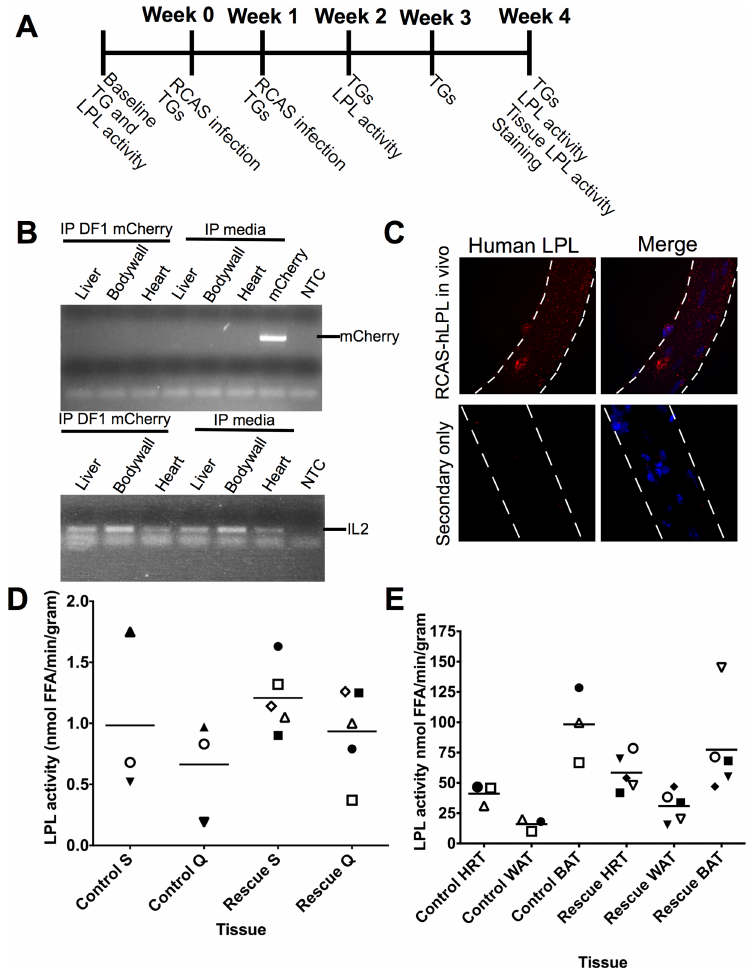
Fig 3. Expression of hLPL in striated muscle following in vivo infection with RCAS-hLPL. A. A schematic of the RCAS rescue strategy and data collectiontime points. RCAS-hLPL or RCAS-mCherry producing cells were injected into mice at week 0 and 1. Fasting serum triglycerides (TG) were measuredat all indicatedtime points. Post-heparin LPL activity (LPL activity) was measuredat baseline, week 2 and week 4 post infection. At 4 weeks post infection, animalswere sacrificed, striated muscle samples analyzedfor tissue specific LPL activity and myofibers isolated to perform immunostaining for hLPL. B. (Upper) Representative PCR for mCherry gDNA from various tissues of mck-Cre;lpl -/+ ;Rosa26 LSLTVA lacZ+/+ mice two weeks post-injection with RCAS-mCherry DF1 cells or media control. No amplification of mCherry was detected in any tissue two weeks post injection.mCherry plasmidwas used as a positive control for amplification. (Lower)Interleukin-2(IL2) gDNA amplification as a control for gDNA input into originalmCherry reaction. NTC = non-template control. n = 3 for each condition. C. Immunofluorescence images of myofibers isolatedfrom mck-Cre;lpl -/- ;Rosa26 LSLTVA lacZ+/- four weeks post injectionwith DF1 cells producing RCAS- hLPL retrovirus. Human LPL immunoreactivity is present throughoutthe myofiber isolatedfrom RCAS-hLPL infected mice and absent from uninjected mice. Nuclei are counterstained with DAPI (blue) and myofibersare outlinedwith dotted lines. D. Tissue-specific LPL activity in soleus muscle (S) or quadriceps muscle (Q) from mck-Cre;lpl -/- ;Rosa26 LSLTVA lacZ+/- mice four weeks after injectionwith RCAS-hLPL DF1 cells (rescue; n = 5) or four weeks post-injection of RCAS-mCherry DF1 cells (control; n = 3). Each symbol represents an individual mouse and bars represent the mean of all samples. E. Tissue specific LPL activity in heart muscle (HRT), white adiposetissue (WAT), or brown adiposetissue (BAT) from mck-Cre;lpl -/- ;Rosa26 LSLTVA lacZ+/- mice four weeks after injectionwith RCAS-hLPL DF1 cells (rescue; n = 5) or four weeks after injectionwith RCAS-mCherry DF1 cells (control; n = 3). WAT and BAT served as positive controls as these tissues produce LPL but do not express MCK. Each symbol represents an individualmouse and bars represent the mean of all samples.